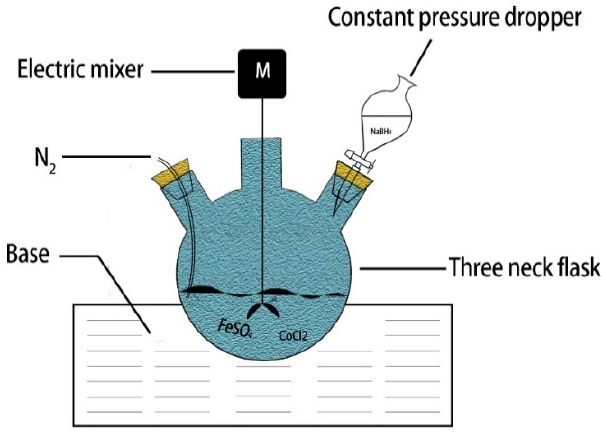
Figure 2. Preparation device of nZVI based materials.